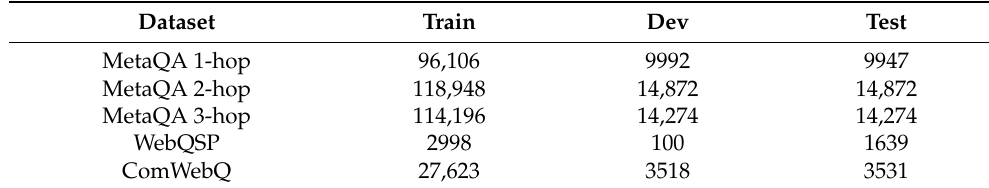
Table 1. Dataset